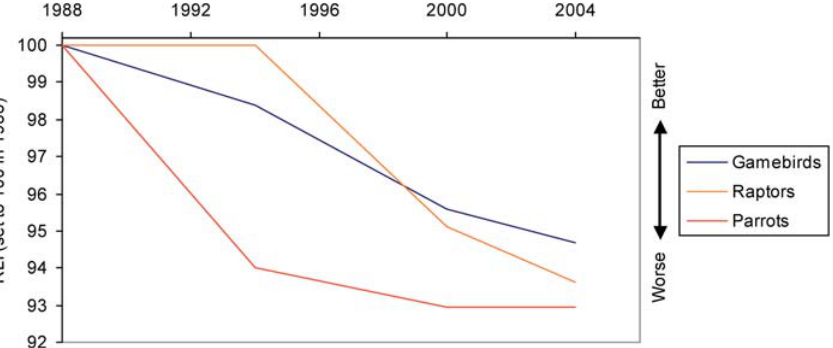
Figure 6. RLIs for Three Bird Families with High Conservation Profiles Sample sizes: game birds, 15 genuine status changes/123 species in categories Extinct in the Wild to Near Threatened in at least one assessment; raptors, 10/93; parrots, 19/148. DOI: